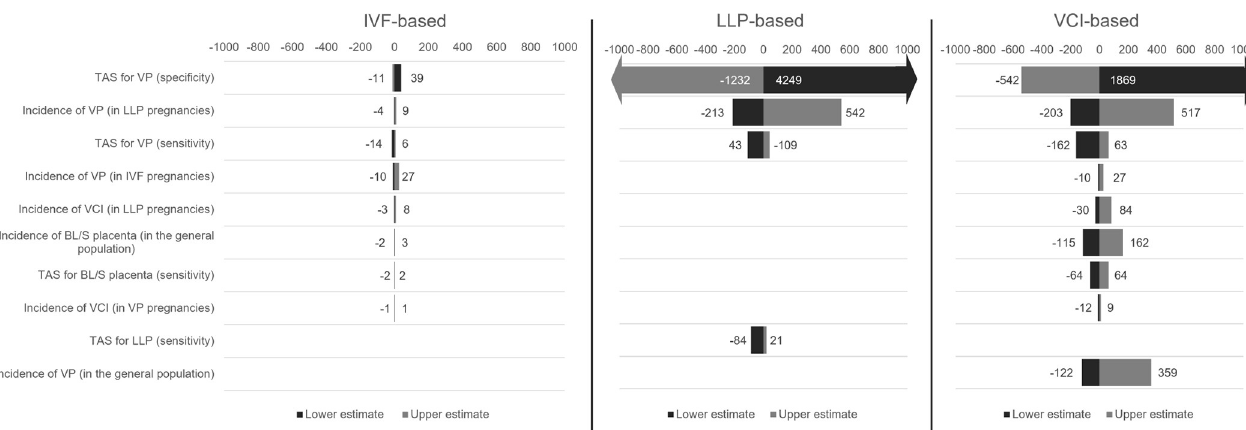
Fig 2. Results of the DSA for the number of referrals to TVS. Upper estimate demonstrates the impact on the difference between each pathway and the no screening pathway in terms of referrals to TVS by increasing the variable; lower estimate demonstrates the impact on the referrals to TVS by decreasing the variable. Asymmetric bars are indicative of input values already being close to the ceiling value for the input type (for example, a probability of 0.9) and therefore being unable to be increased to the full extent. Abbreviations : BL/S, bilobed or succenturiate; DSA, deterministic sensitivity analysis; IVF, in vitro fertilisation; LLP, low-lying placenta; TAS, transabdominal sonography; TVS, transvaginal sonography; VCI, velamentous cord insertion; VP, vasa praevia.